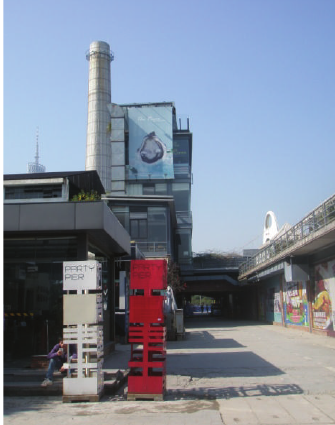
Figure 12: A logo of Party Pier.